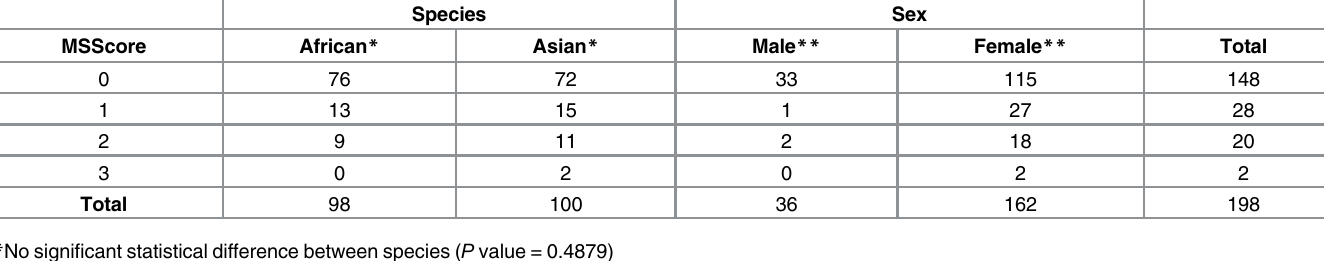
Table 2. Frequency of MS scores among African and Asian elephants during 2012 Physical